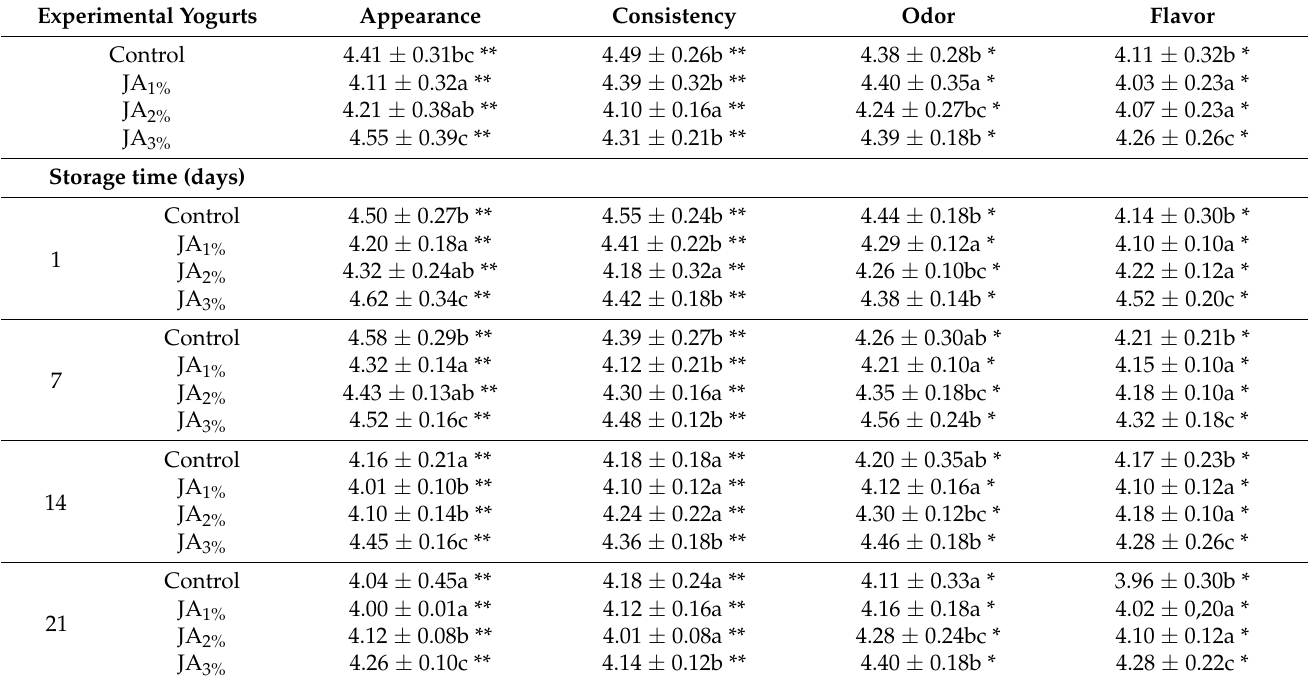
Table 4. The sensory evaluation of experimental yogurts depends on JA ratios and storage times (mean ±